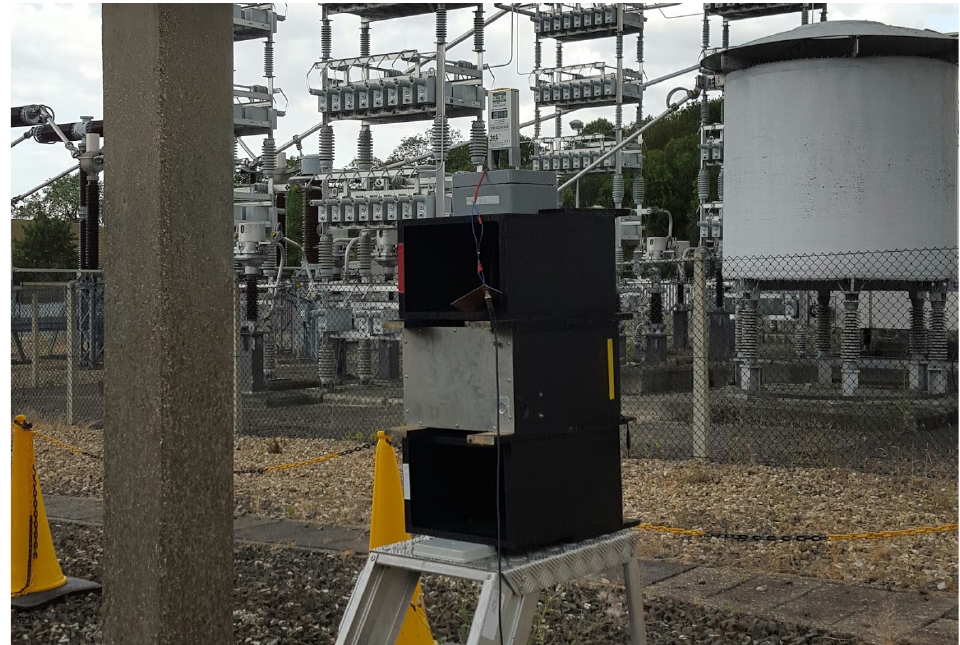
Figure 6. Experimental setup showing the arrangement adopted for the FM directly underneath the busbar connected to the charged